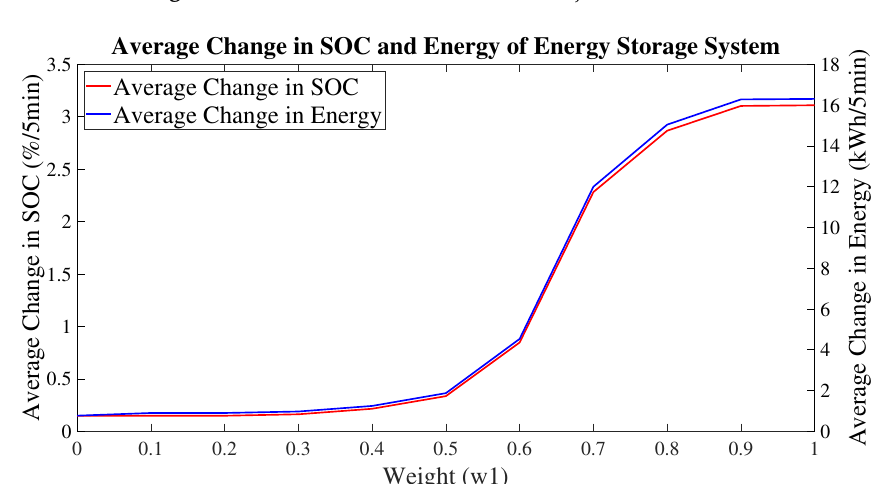
Figure 7. Normalized effect of the multi-objectives function.